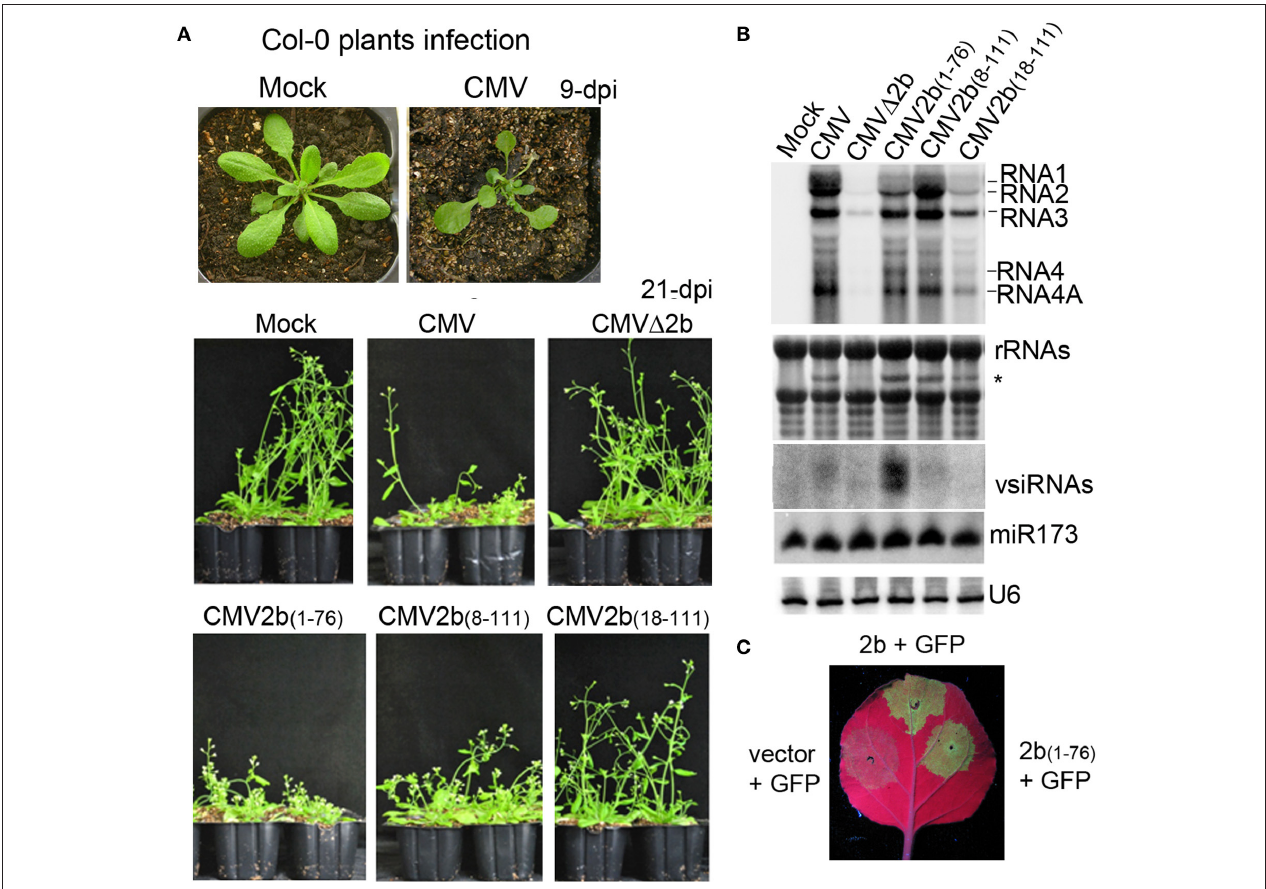
FIGURE 4 | Effects of 2b and its mutants on the virulence and accumulation of viral RNAs in infection with wild-type Arabidopsis plants. (A) Disease symptoms in wild-type Arabidopsis plants inoculated with CMV and CMV2b (x) at 9 dpi and 21 dpi. (B) RNA gel blot detection of viral genomic RNAs and vsiRNAs. Methylene blue-stained ribosome rRNA and U6 were used as the loading control. (C) GFP fluorescence in the leaves of Nb plants coinfiltrated with GFP and 2b or mutants. Coinfiltration of GFP with vector was used as